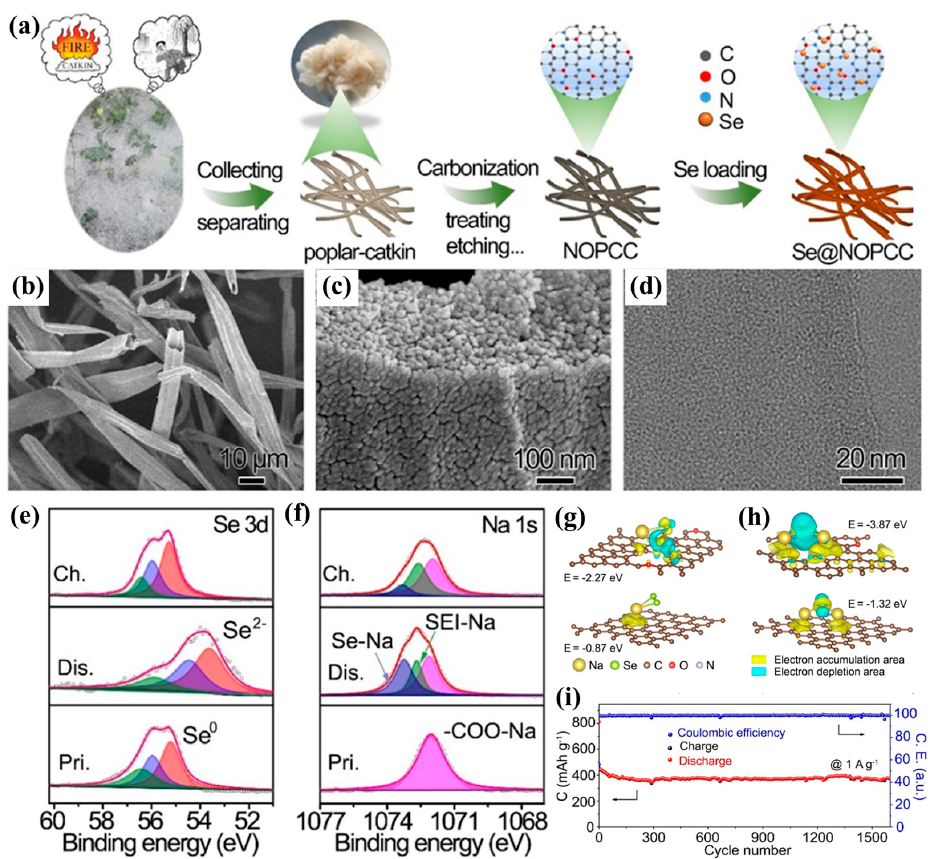
Figure 5. ( a ) Schematic diagram of Se@NOPCC synthesis; ( b , c ) typical SEM images and ( d ) HRTEM image of Se@NOPCC. ( e , f ) Ex situ Se 3d and Na 1s XPS spectra of the Se@NOPCC electrode in the discharge/charge processes, respectively (Pri., pristine state; Dis., discharged state; Ch., charged state); ( g ) simulated charge distribution between NaSe 2 and defective carbon (up) or regular carbon (down); ( h ) simulated charge distribution between Na 2 Se and defective carbon (up) or regular carbon (down). The yellow and cyan areas represent the increase and decrease in electron density, respectively. The isosurface is 0.002 e bohr − 3 . ( i ) Long cycling stability at 1.0 A g − 1 of the Se@NOPCC electrode. Reproduced with permissions from the ref. [61] Copyright © 2021 American Chemical